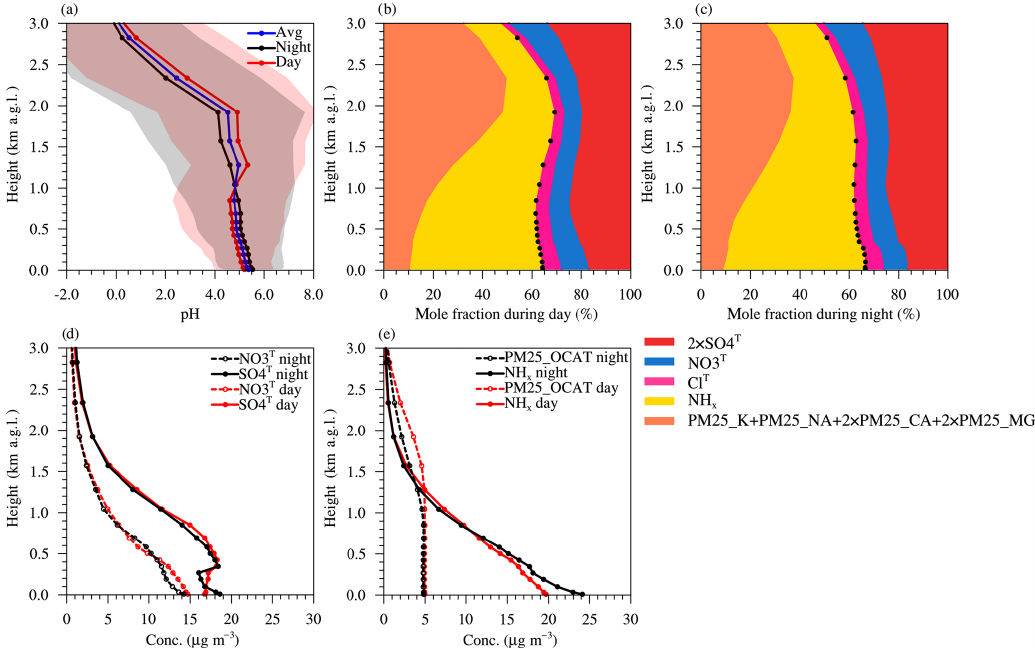
Figure 3. Vertical profiles of the fine particle pH and its potential influencing factors over the Beijing TSU site. The data are simulated with the CTRL scenario during January 2013 and presented at height above ground level (a.g.l.). (a) Monthly average pH (blue), as well as daytime (red) and nighttime (black) average pH (standard deviations are shown in light red and light gray shading, respectively). (b) Daytime mole fractions for the electric charge of total ammonia (NH x ), total chloride (Cl T ), total sulfate (SO4 T ), total nitrate (NO3 T ), and different crustal components of PM 2 . 5 , and the black dots represent the vertical profile of cation T / (cation T + anion T ). (c) The same as in (b) but for the nighttime. (d) Daytime (red) and nighttime (black) concentrations of total sulfate (SO4 T ) and total nitrate (NO3 T ). (e) Daytime (red) and nighttime (black) concentrations of NH x and